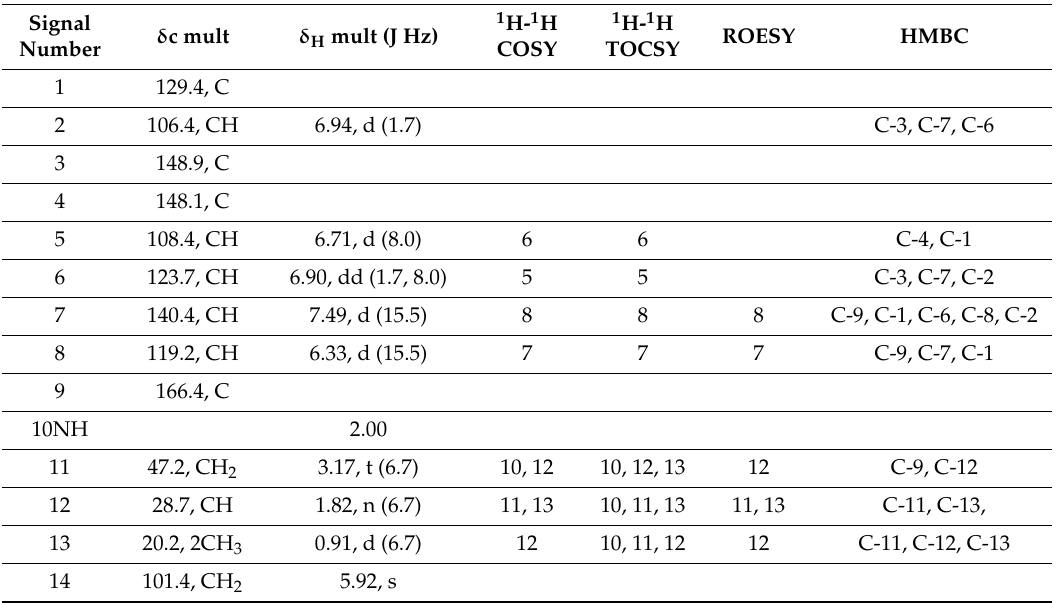
Figure 2. Key homonuclear correlation spectroscopy (COSY) and total correlation spectroscopy (TOCSY) (bold lines), 1 H- 13 C HMBC (single arrows), rotating-frame Overhauser spectroscopy (ROESY) (double arrows) correlations for compound 1 . Table 1. 1D and 2D-NMR spectroscopic data for compound 1 in CDCl 3 , in